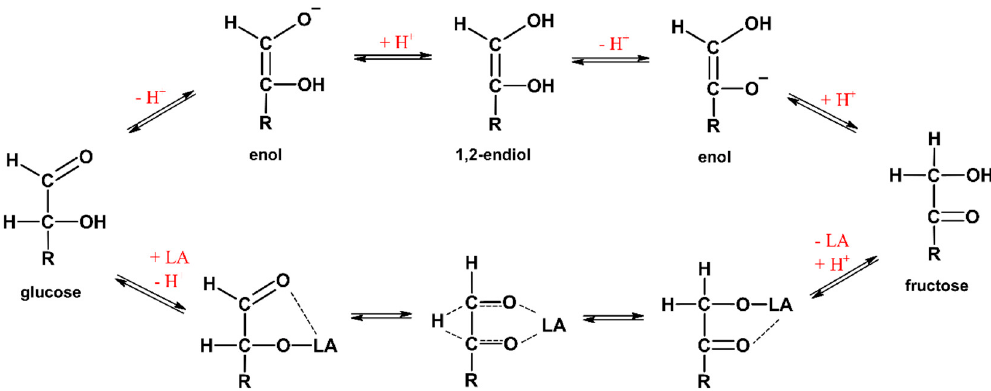
Figure 1. Mechanistic scenarios for isomerization of glucose to fructose [6], Brønsted base-catalyzed keto-enol tautomerism with hydrogen transfer (top) and Lewis acid-catalyzed intramolecular hydrogen shift (bottom), LA: Lewis acid.